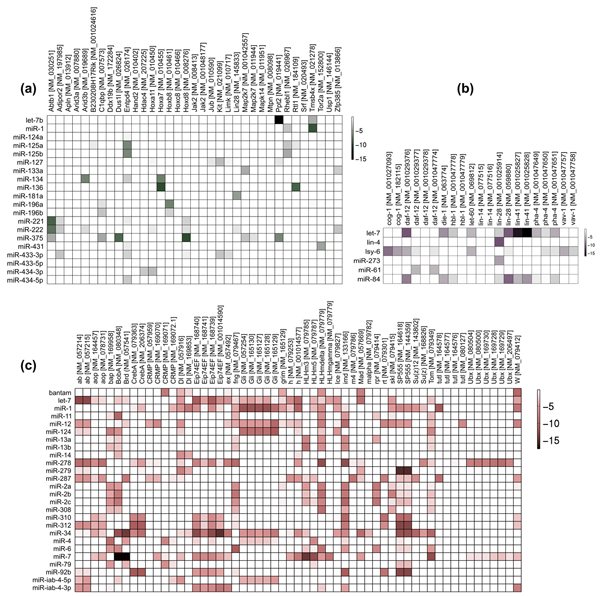
Energies of predicted miRNA targets. A density plot of free energies of the most stable predicted miRNA-target duplex for each gene-miRNA pair in (a) mouse, (b) C. elegans, and (c) Drosophila, with genes along the x-axis and miRNAs along the y-axis. A more negative free energy indicates a more stable duplex, relative to its unbound mRNA. Darker colours indicate lower free energies, as shown by the scale in the top-right corner of each sub-figure. White squares indicate no predicted interaction.